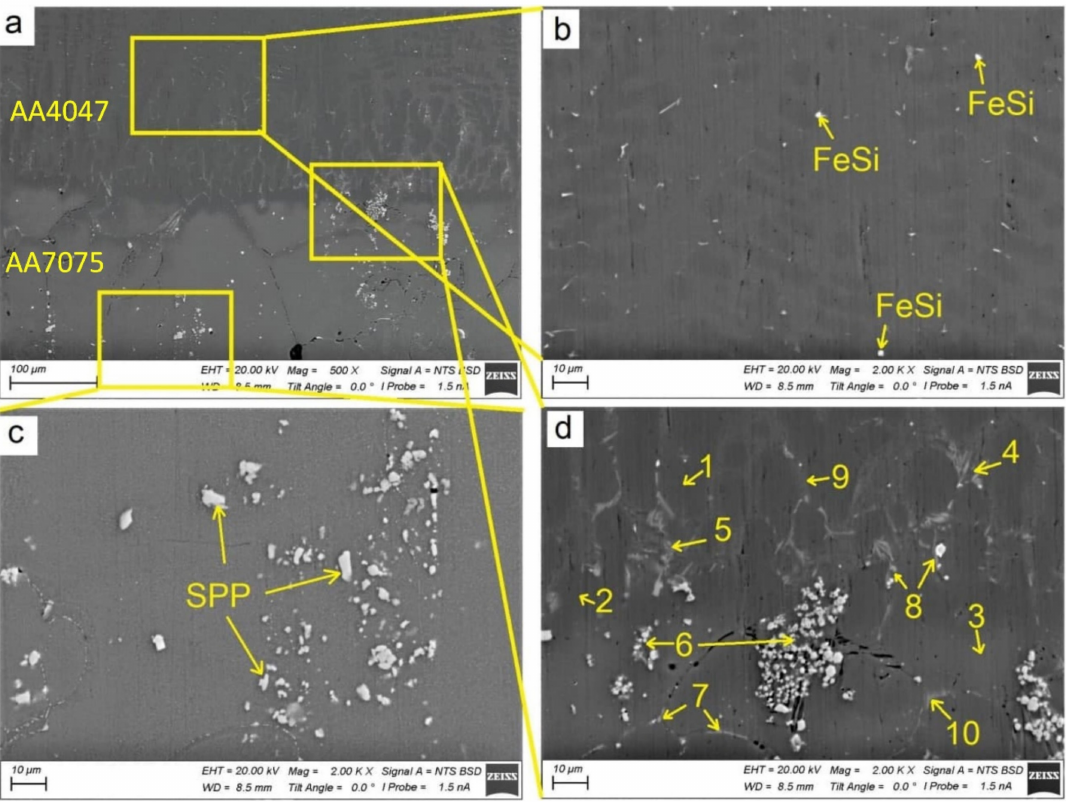
Figure 3. SEM BSE images of Al-Zn-Mg-Cu/Al-Si transition zone ( a , d ), Al-1i EBAM part ( b ), AA7075 substrate part ( c ). 1–3—Al-rich, 4–5—Si-rich, 7–8—Si-Mg-Cu-Zn, 9–10—Si-medium. SPP—secondary phase